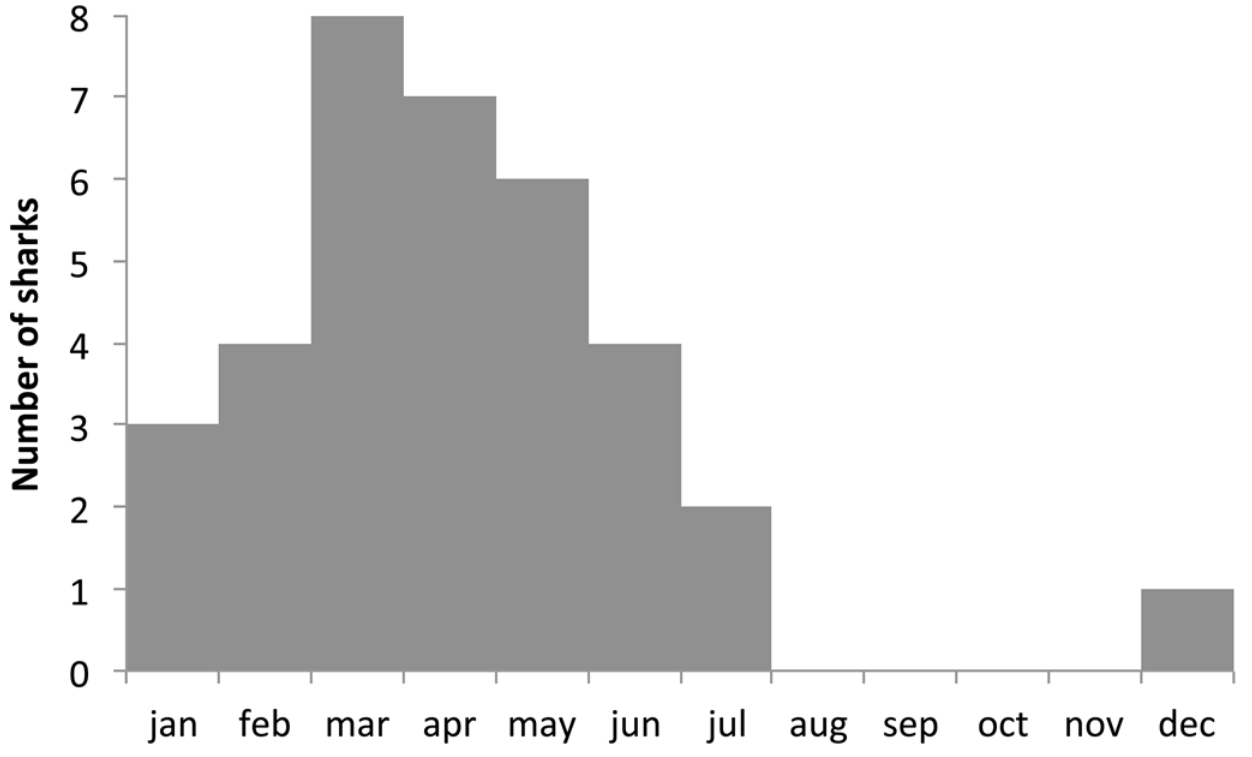
Fig 7. Number of oceanic whitetip sharks monitored per